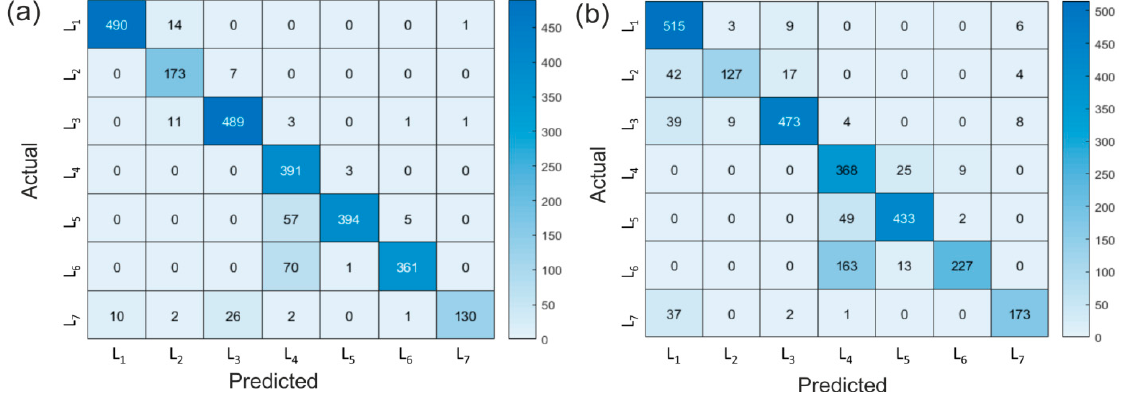
Figure 10. Confusion matrices obtained by using the test data, where in each matrix the element of the row i and column j indicates the number of cases where a time series actually L i is classified as L j (therefore, the main diagonal shows the correct predictions): ( a ) CNN trained with rainfall and velocity scalograms; ( b ) CNN trained with rainfall scalograms only.